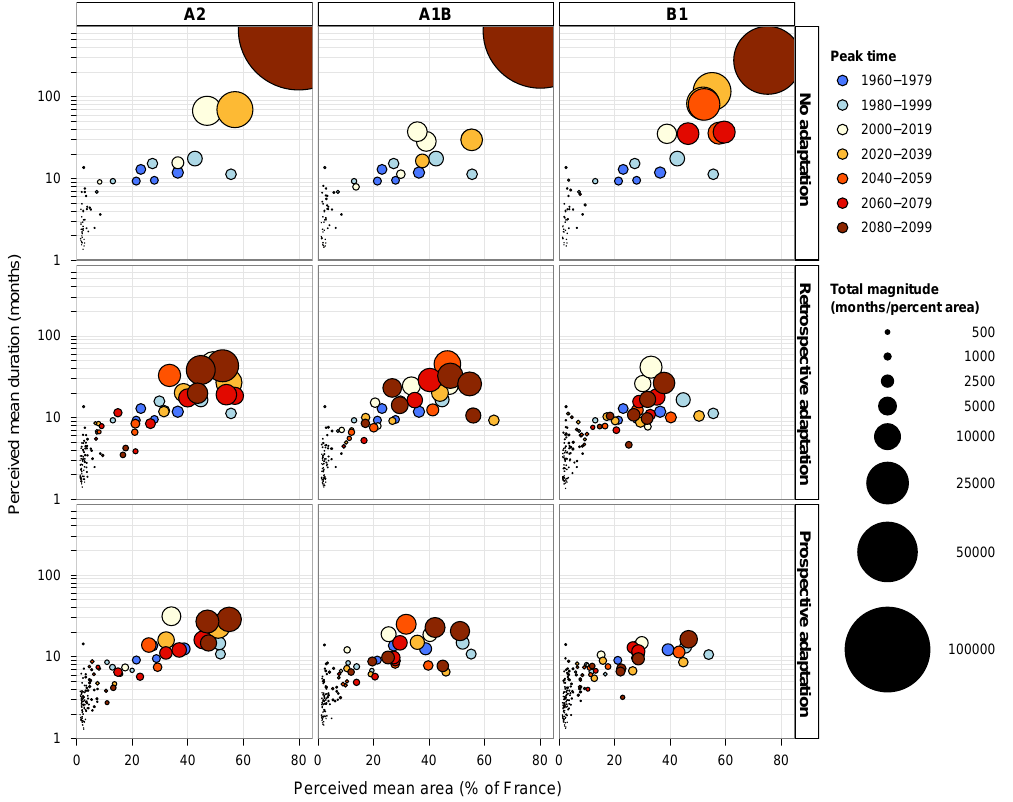
Fig. 10. As for Fig. 7, but for long agricultural droughts, as defined by